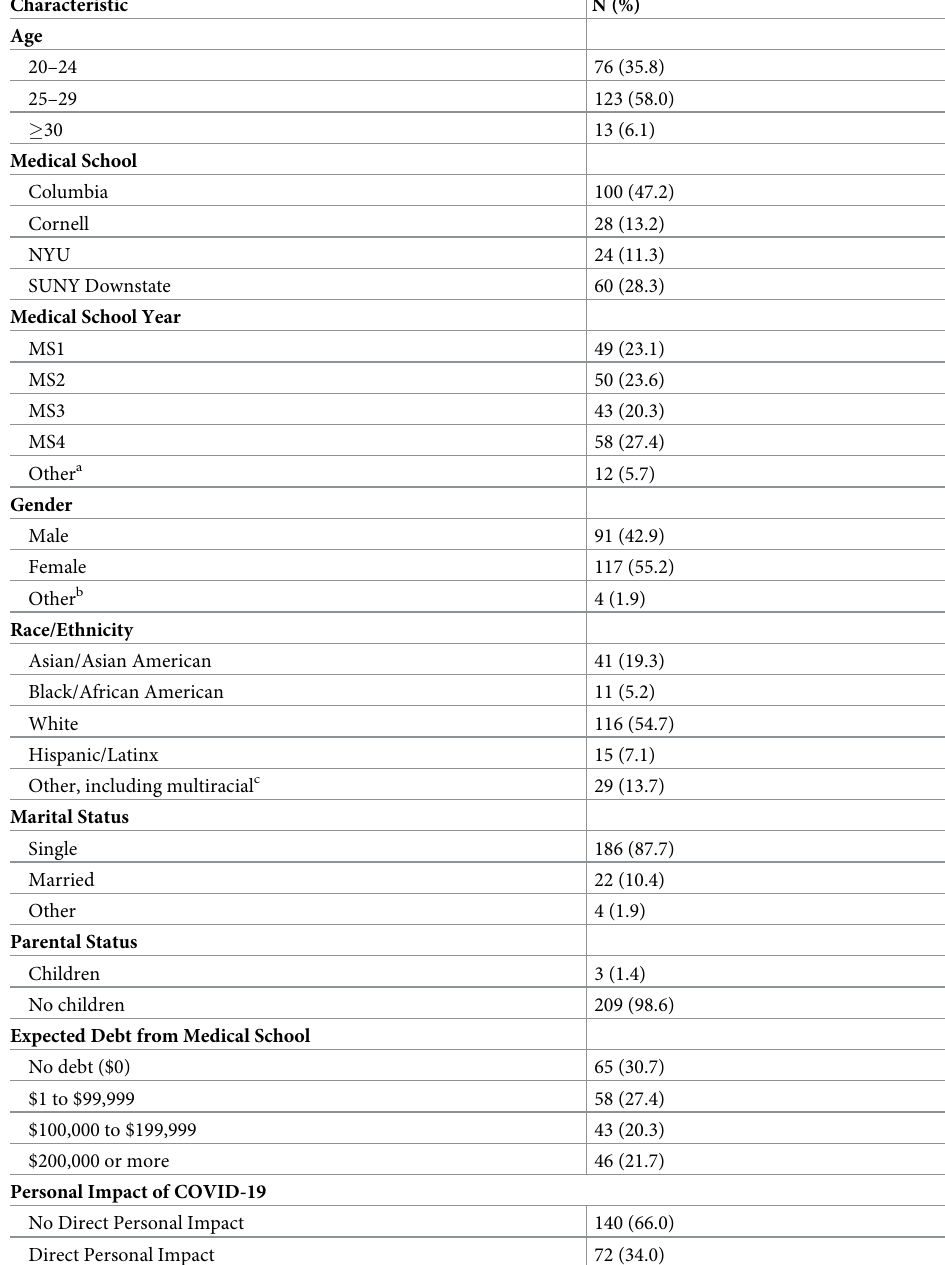
Table 1. Characteristics of 212 New York City medical student